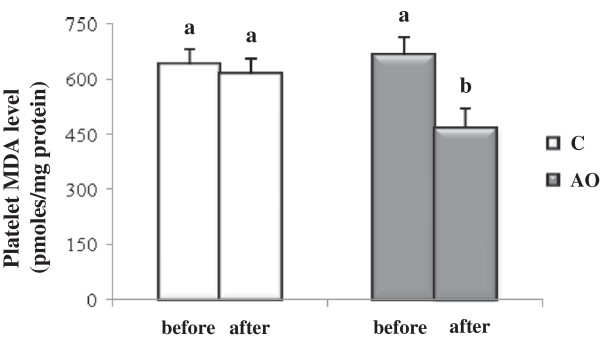
Platelet malondialdehyde (MDA) level after 3 weeks of nutritional intervention with argan oil. Comparisons are made between the platelet MDA level before and after the intervention period in the two groups. C: control group; AO: argan oil group. After a one-way ANOVA, Student-Newman-Keuls multiple comparison test, results are arranged in increasing order from left to right a > b (p < 0.05).